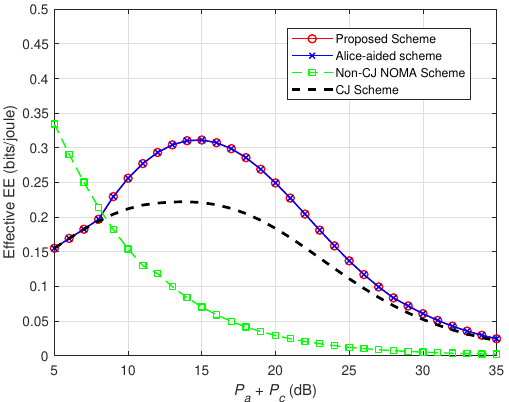
Figure 5. Effective energy efficiency vs. the total transmit power P a + P c